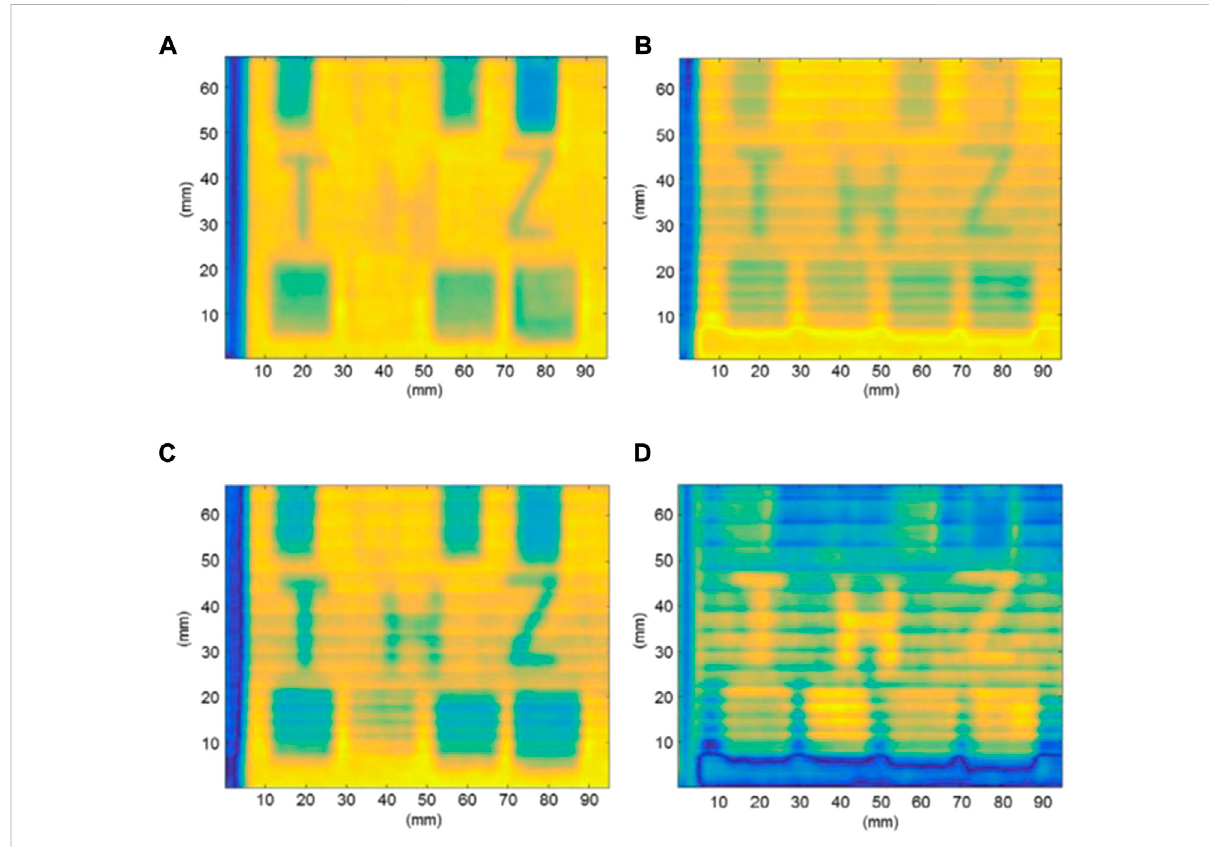
FIGURE 8 THz transmission C-scan visualization images obtained at 0.225 THz: (A) magnitude map; (B) phase map; (C) real-component map; (D) imaginary-component map (Han and Kang,